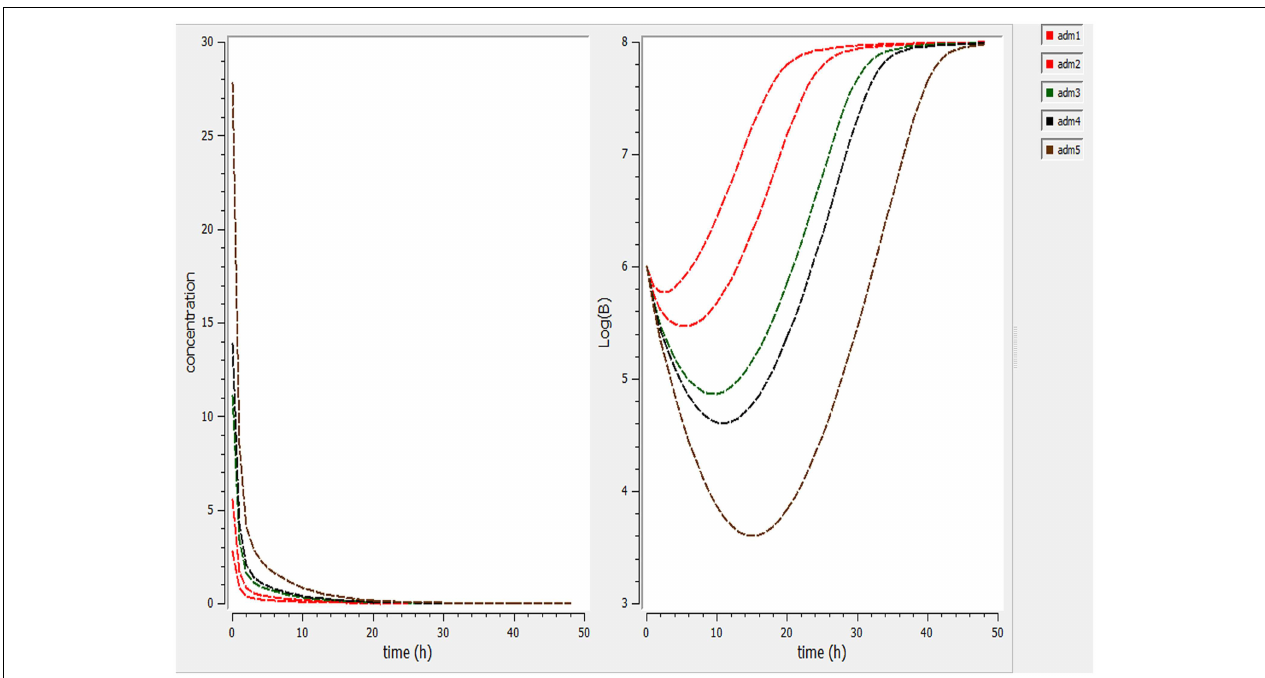
FIGURE 4 | Simulate the effect of different doses (0.5, 1, 2.5, 5, 7.5mg/kg). The effect of different doses were observed on bacteria and its